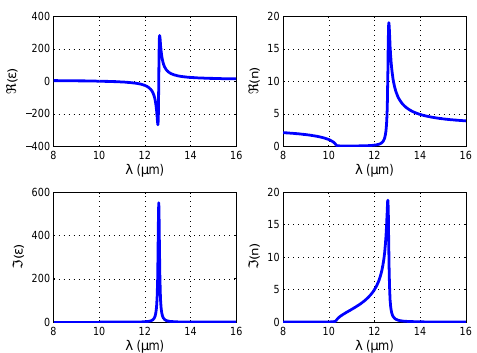
Figure 8: Real (left-top) and imaginary (left-bottom) parts of the permittivity of silicon carbide obtained from Eq. (9), as well as the real (right-top) and imaginary (right-bottom) parts of the corresponding refractive index.